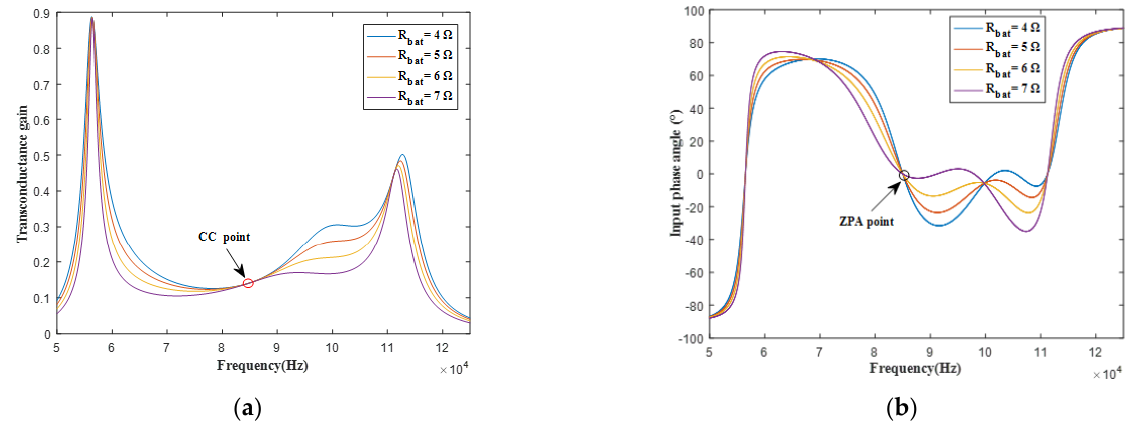
Figure 5. ( a ) Transconductance gain of the DS-LCC topology; ( b ) input phase angle of the input equivalent impedance.